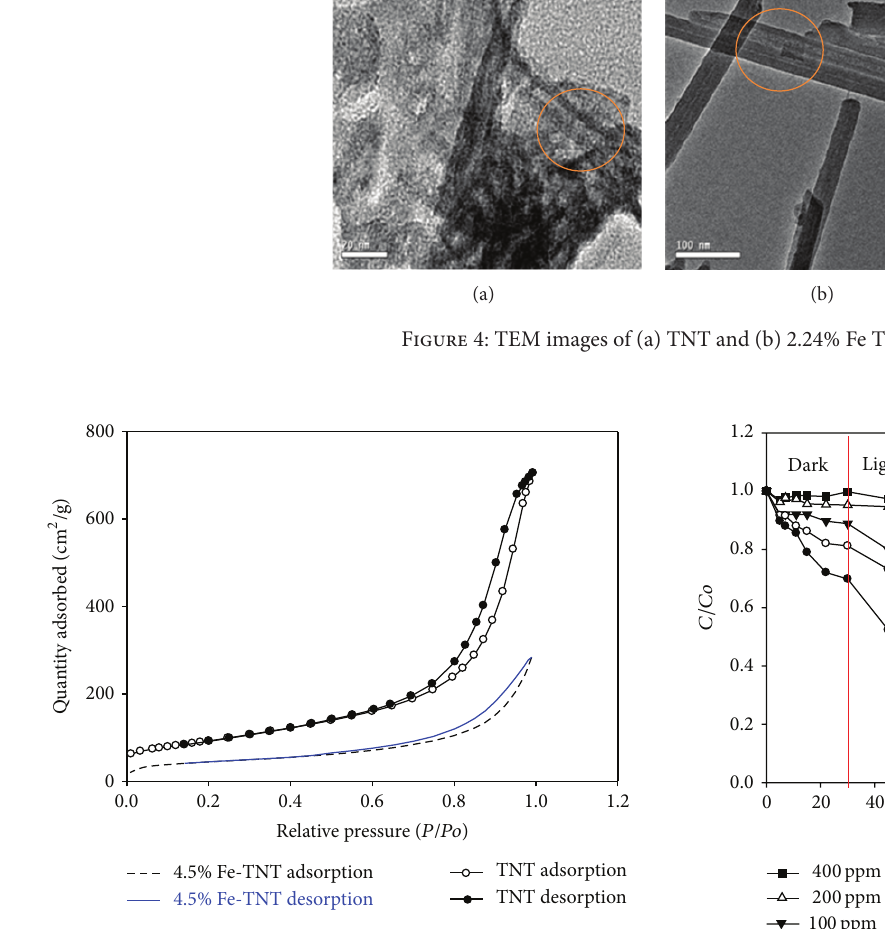
Figure 6: The effect of initial concentration on degradation effi- ciency under 254 nm UV and 1.13 % Fe-TNT of 0.04 gL −1